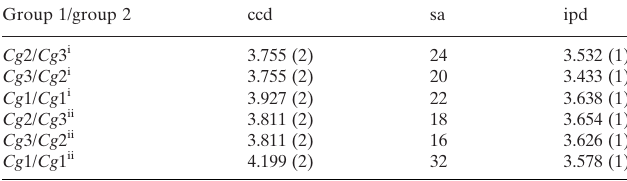
Data collection: APEX2 (Bruker, 2007); cell refinement: SAINT (Bruker, 2007); data reduction: SAINT ; program(s) used to solve structure: SHELXS97 (Sheldrick, 2008); program(s) used to